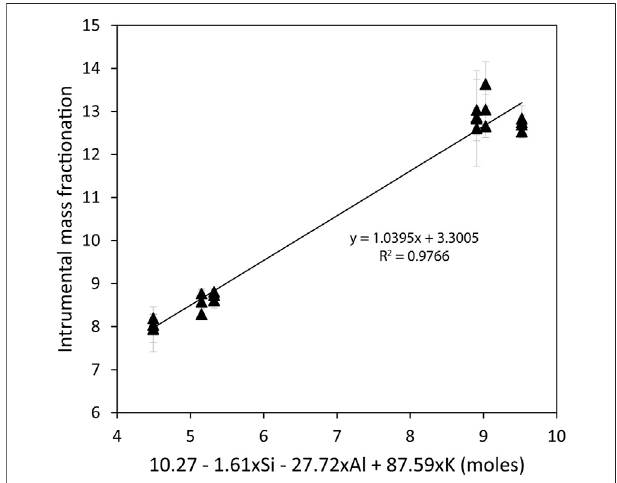
FIGURE3| Instrumentalmassfractionationplottedagainsttheequation de fi ned by Manzini et al. (2017). The different reference materials used are the same as in Manzini et al. (2017) and all have more than 1,000 μ g/g Cl.